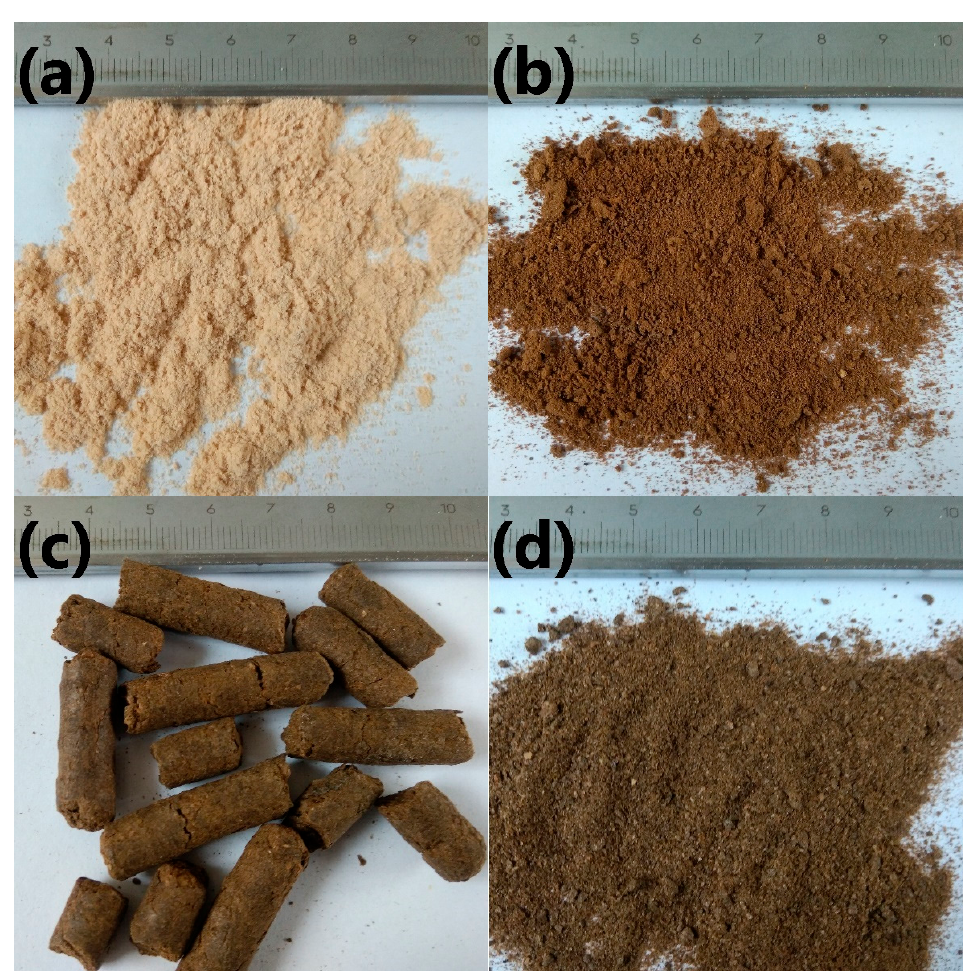
Figure 1. The appearance of the ( a ) beech wood flour, ( b ) modified brewers’ spent grain, as well as coffee silverskin ( c ) before and ( d ) after grinding.